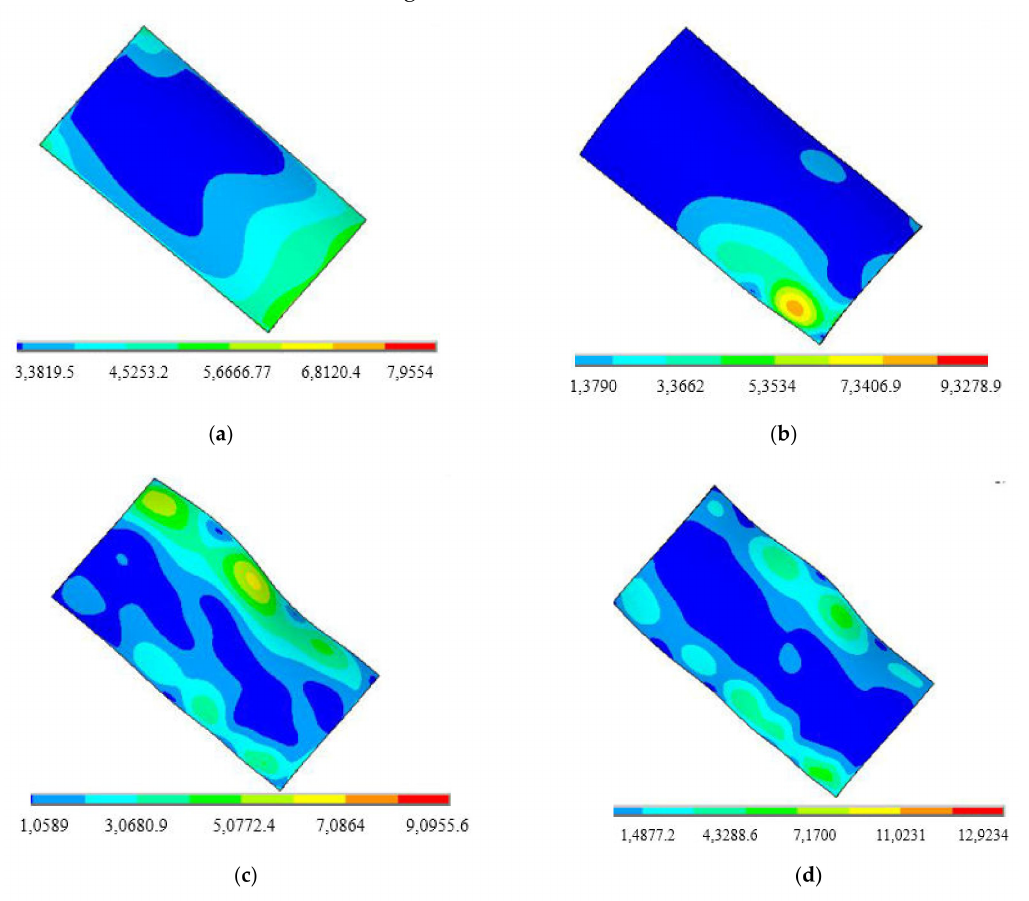
Figure 13. The non-linear buckling stress distribution of blades. ( a ) The first-order, ( b ) the second-